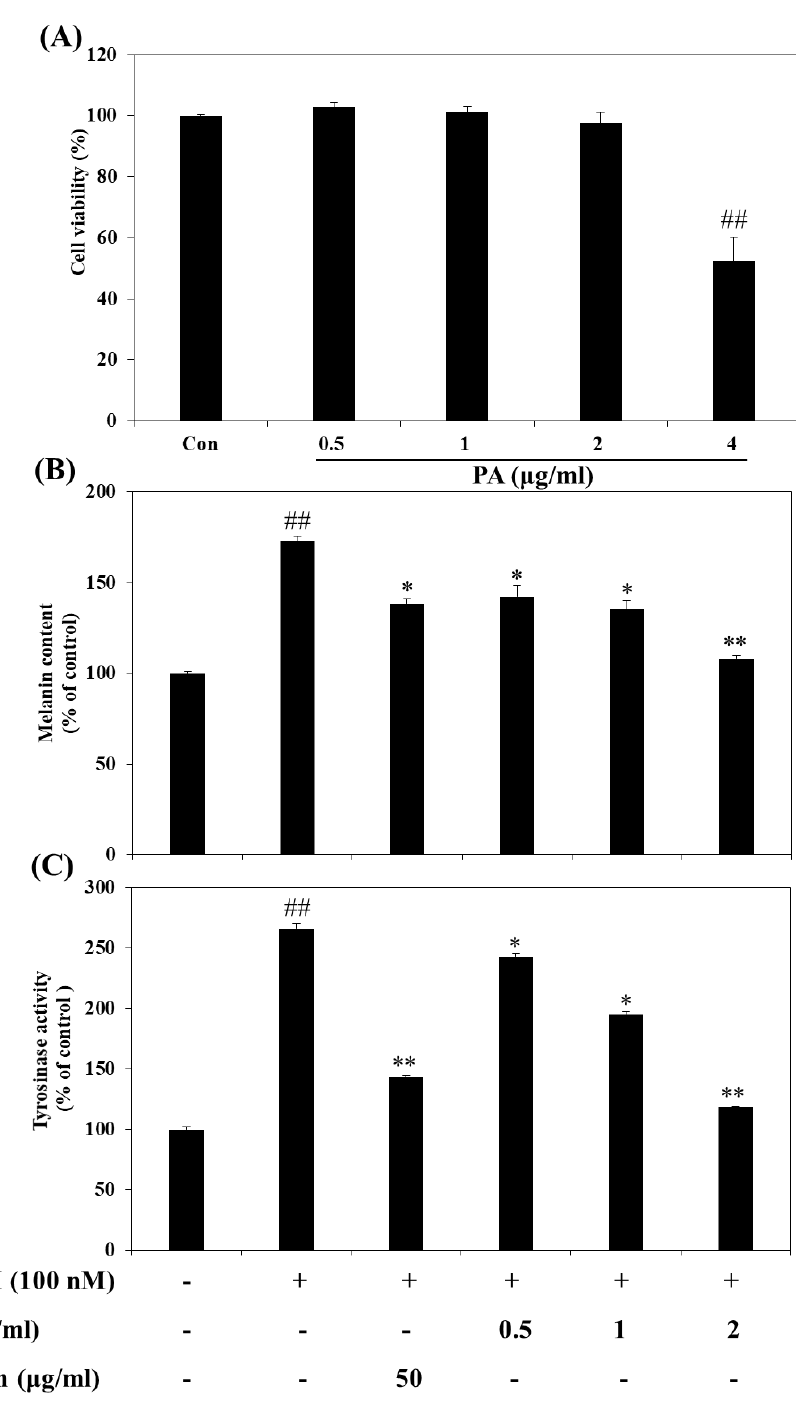
Figure 2. Effects of PA on cellular melanin synthesis and intracellular tyrosinase activity in α -melanocyte stimulating hormone ( α -MSH)-stimulated B16F10 cells. Cells were treated with the indicated concentrations of PA for 72 h and then cell viability was determined by the 3-(4,5-dimethylthiazol-2-yl)-2,5-diphenyltetrazolium bromide (MTT) assay ( A ). The relative cellular melanin content ( B ) and intracellular tyrosinase activity ( C ) were measured at 72 h after treatment. Cells were exposed to 100 nM α -MSH in the presence of PA at the indicated concentrations or 50 µg/mL arbutin. Values are expressed as means ± SDs of triplicate experiments ( n = 3). Note: ## p < 0.01 compared to the untreated control group; * p < 0.05 and ** p < 0.01 compared to the α -MSH only group.